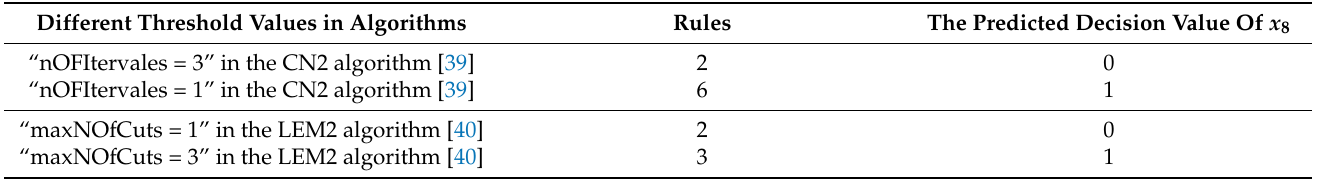
Table 10. The decision results of x 8 utilizing different threshold values for Example